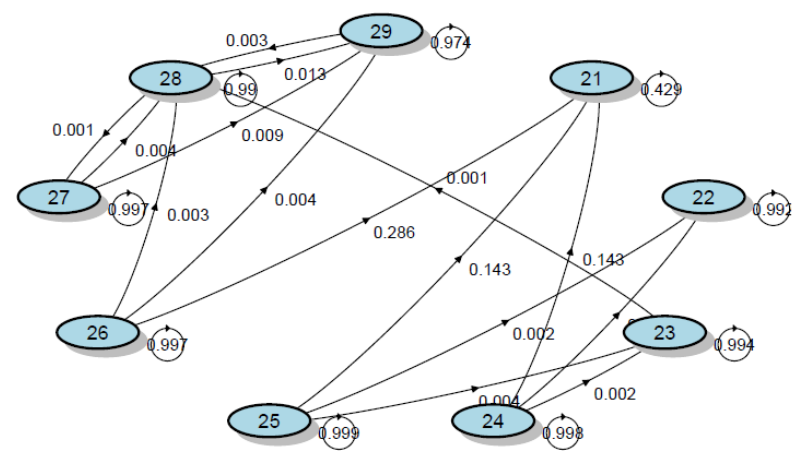
Figure 1. Visualisation diagram of the transition matrix of one of the devices. Transition probabilities smaller than 0.001 have been taken out of the diagram for the better visualisation of the dominant transitions.